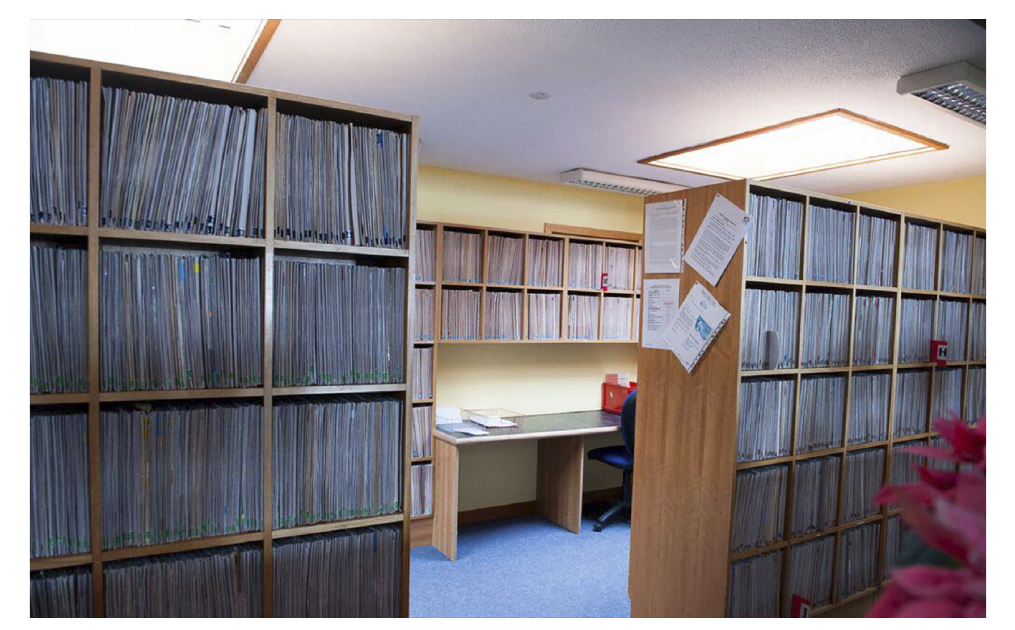
Figure 5. Visible banks of case